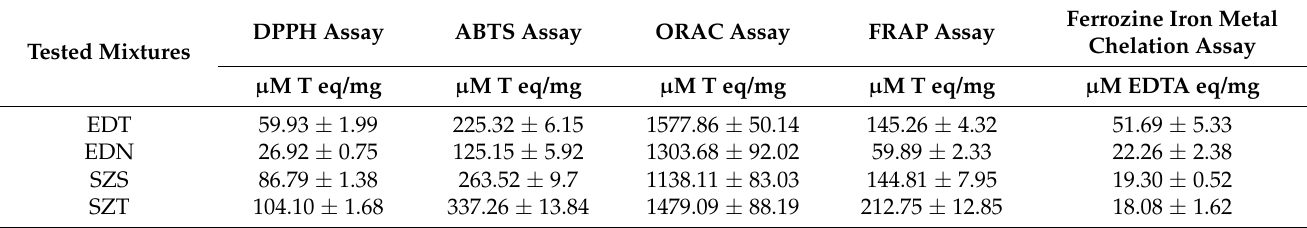
Table 4. Antioxidant potential of the tested herbal